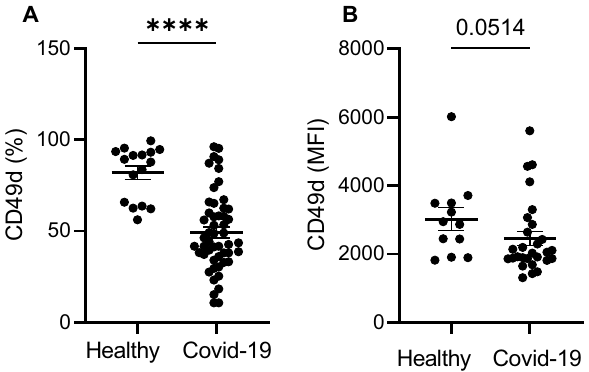
Figure 4. Neutrophils from COVID-19 patients present with significantly lower expression of CD49d compared with healthy individuals ( A , B ).